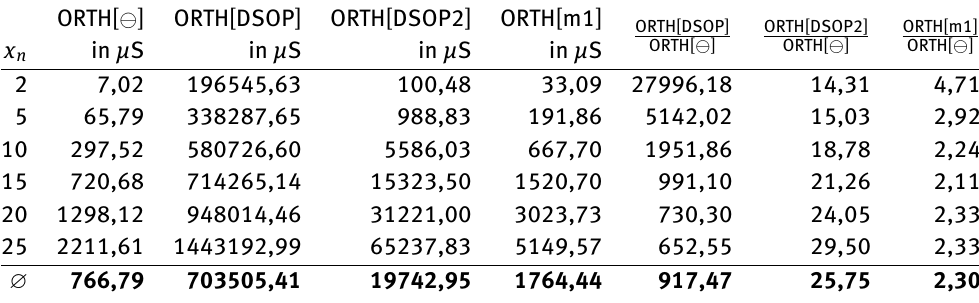
Table 4: Average of the computation times and relation to ORTH [ ⊖ ]